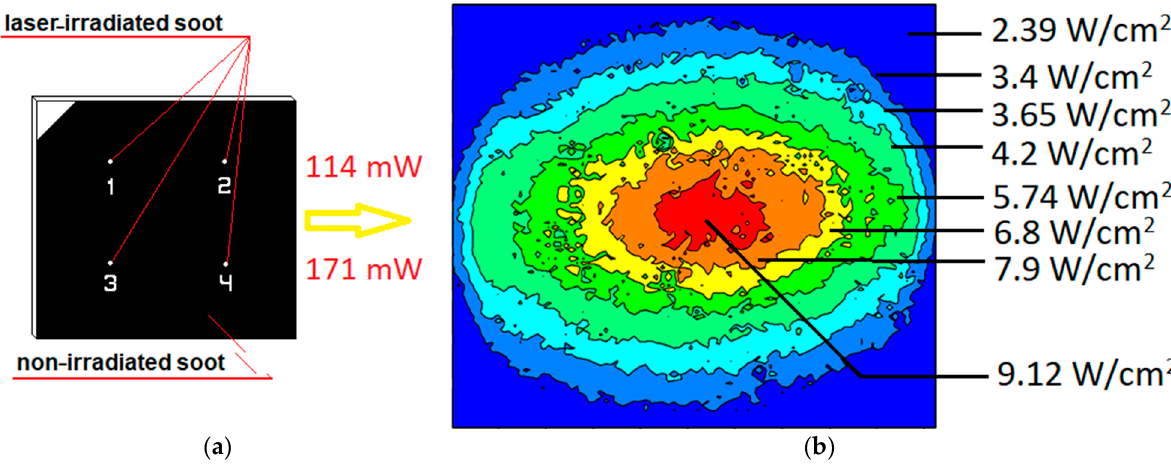
Figure 2. Arrangement of the irradiated soot regions ( a ) and representation of the Gaussian distribution of the laser spot ( b ).